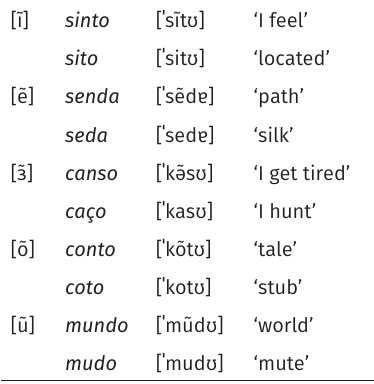
Table 1: Minimal pairs examples of contrasting nasal versus oral vowels in stressed